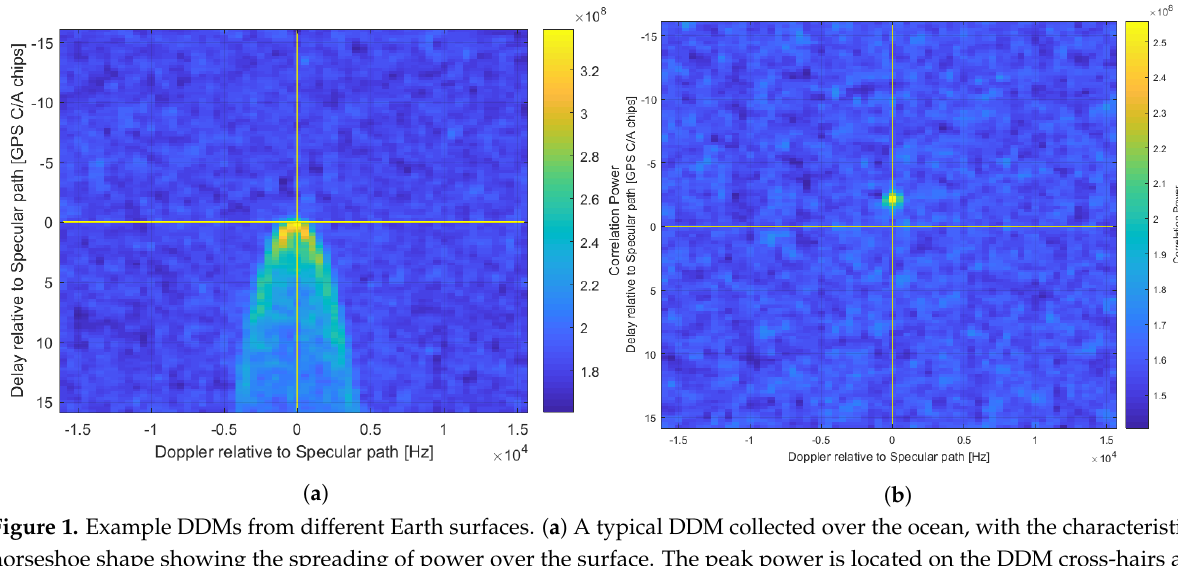
Figure 1. Example DDMs from different Earth surfaces. ( a ) A typical DDM collected over the ocean, with the characteristic horseshoe shape showing the spreading of power over the surface. The peak power is located on the DDM cross-hairs as the specular point has been predicted with sufficient accuracy by the quasi-spherical model. ( b ) A DDM from a dataset over low-elevation mountains in South Sudan (approximate elevation 500 m). The cross-hairs represent the predicted reflection point, showing the effect of topography on the location of the peak reflected power in the